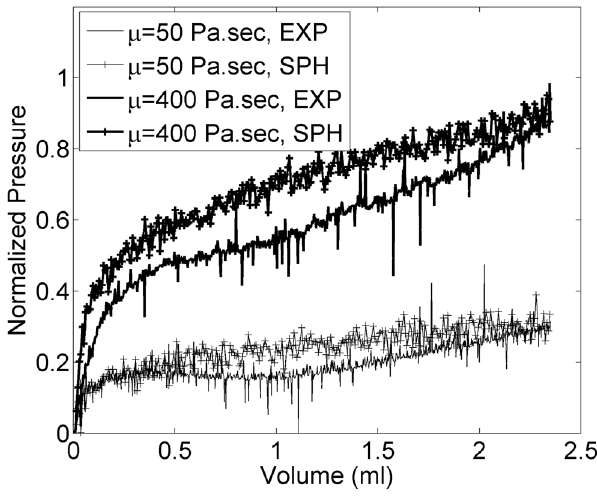
Figure 10. Normalized pressure over the course of injection for example viscosity extremes.